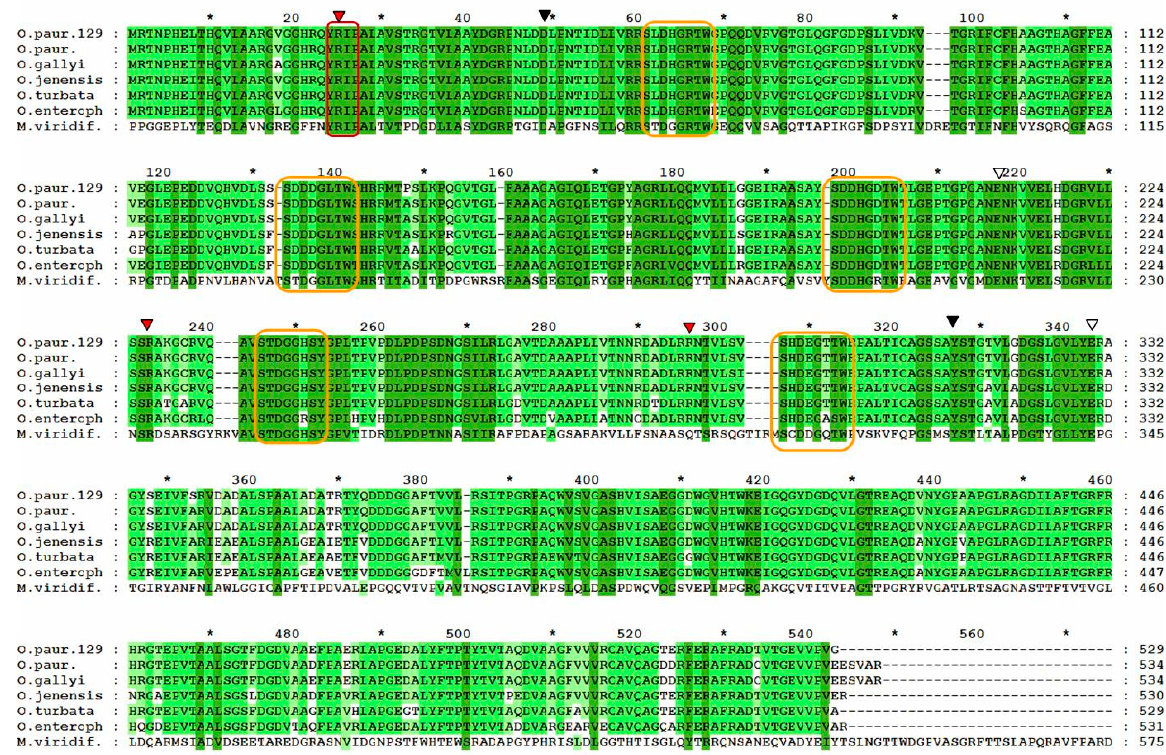
Figure 7. Amino acid sequence alignment of the novel O. paurometabola O129 sialidase (NCBI Gen- Bank accession number OP429228) with the deduced amino acid sequences of the enzymes of O.